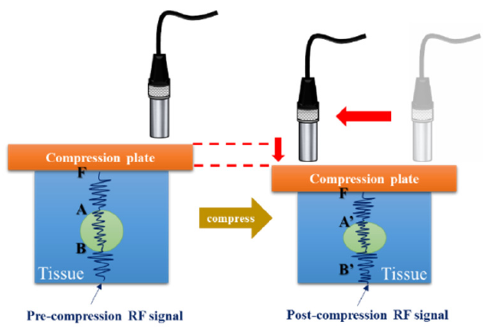
Figure 9. The schematic diagram of tissue before and after compression. RF: radio frequency.